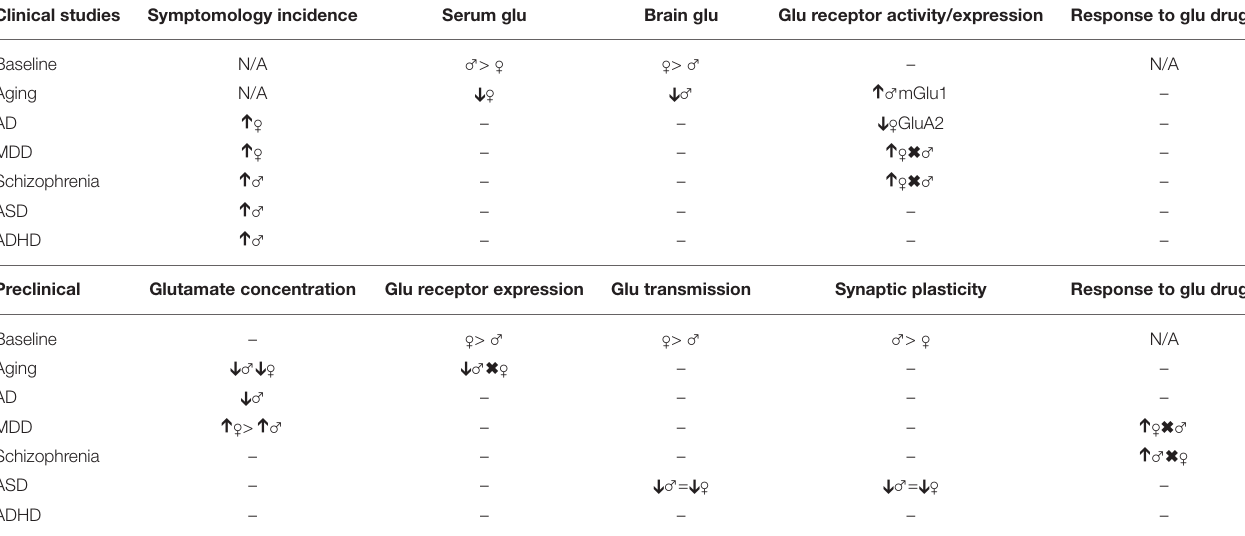
TABLE 1 | Sex differences in glutamate systems in